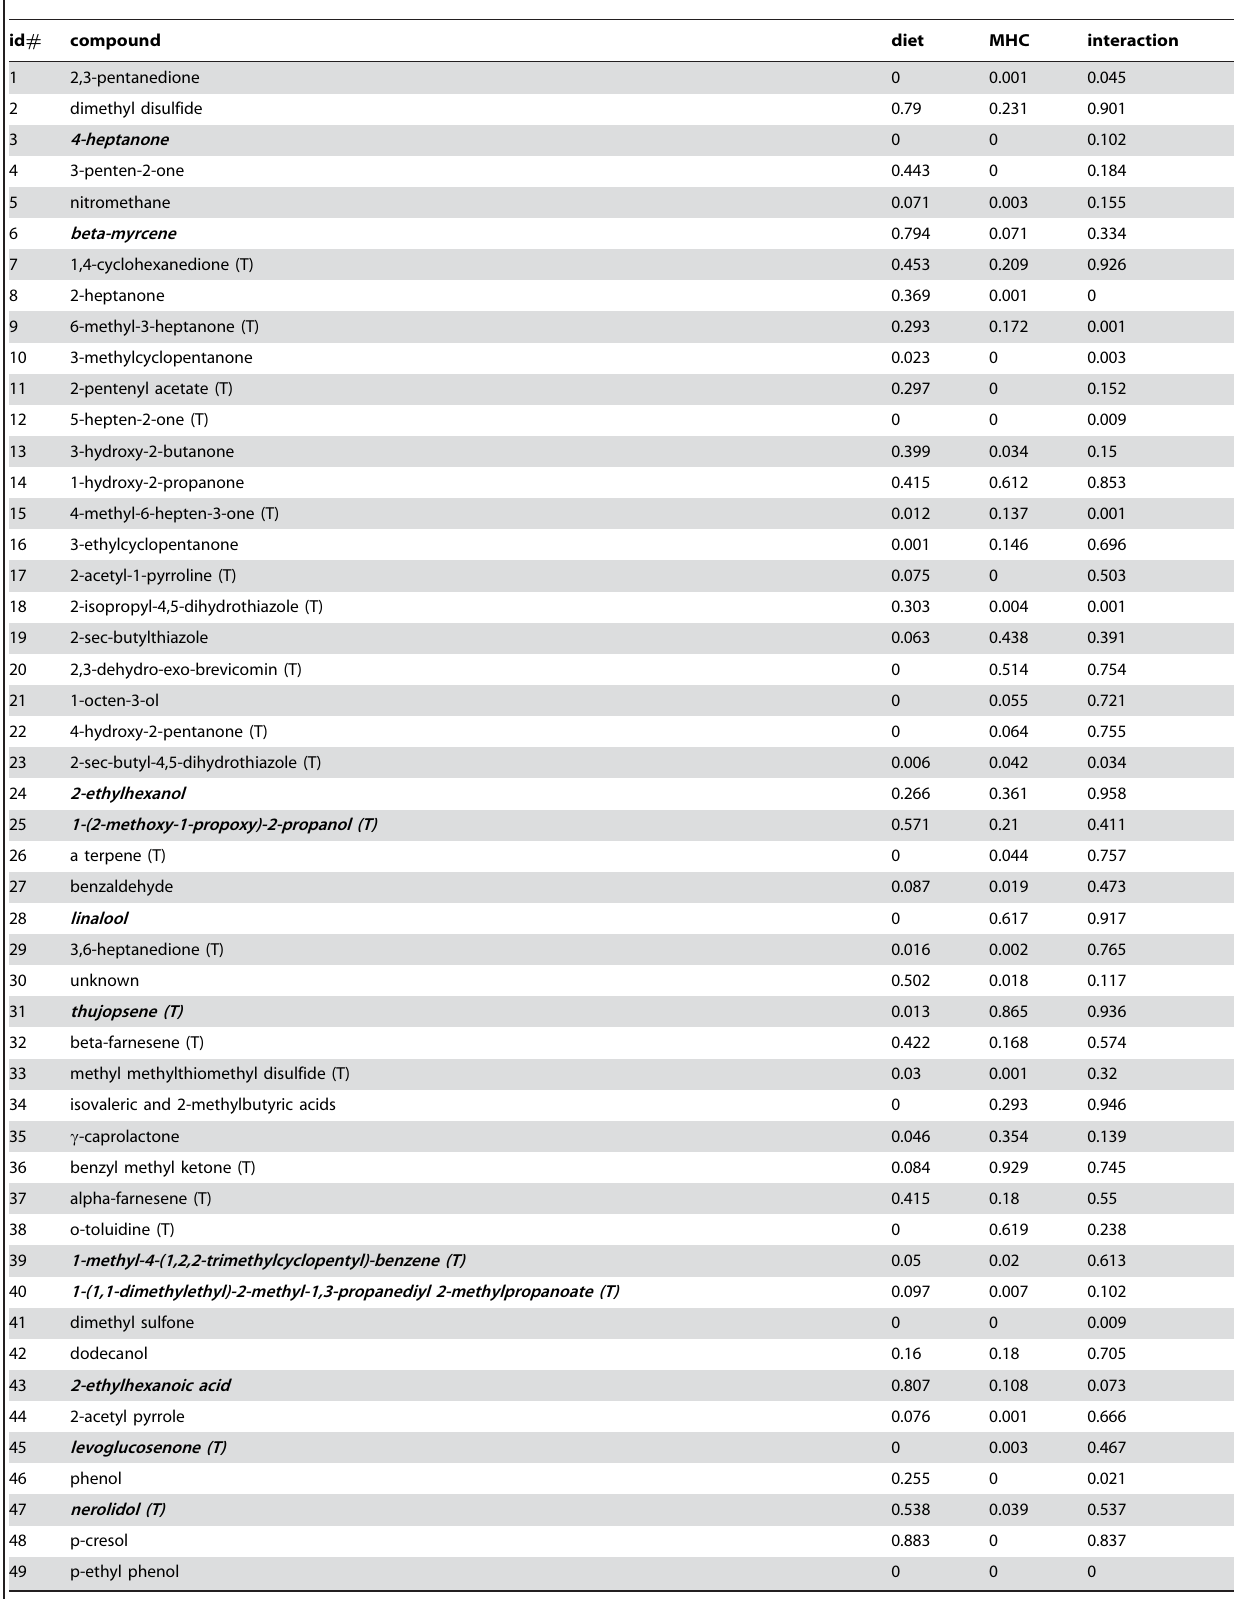
Table 3. Compounds identified in mouse urine, and their statistical